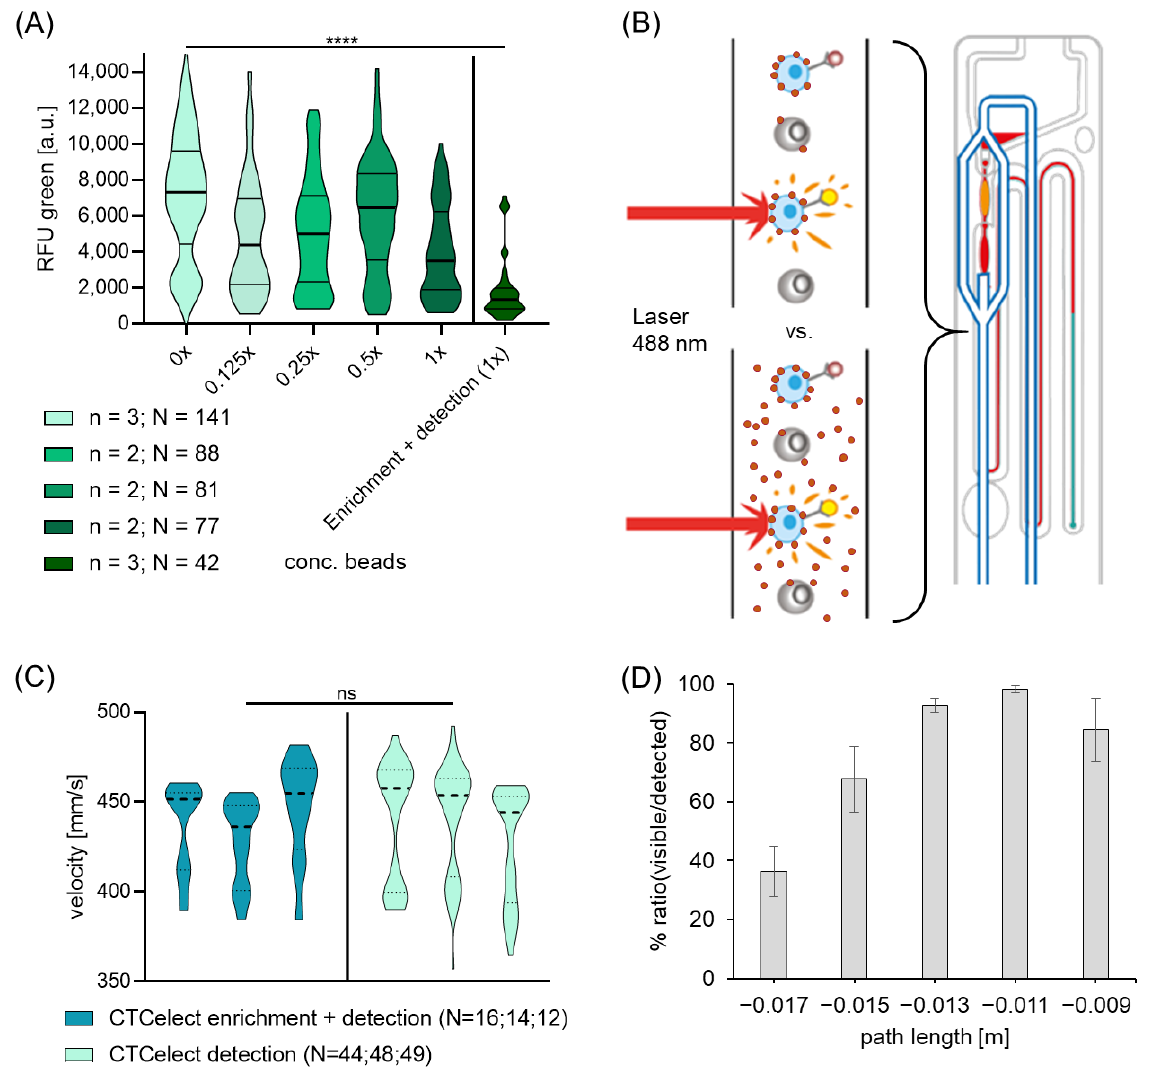
Figure 3. Characterization of fluorescence and flow properties of bead-bound single cells. ( A ) The relative fluorescence intensity of CFSE stained bead-bound MCF-7 cells (in RFU) was recorded with our microfluidic flow cytometry subunit in dependency of free beads in the channel ( x -axis) and previous automated enrichment. Relative fluorescence is presented as violin plot with median and first and third quantile (one-way anova, with Tukey’s multiple comparisons test, **** p < 0.0001). ( B ) Explanatory illustration of single cell detection in the microfluidic cartridge with or without free beads. ( C ) The velocity of bead-bound single cells was measured in the detection channel of the chip and compared between manual bead incubation (436 mm/s) and previous automated immunomagnetic enrichment (437 mm/s). Velocity is given as violin plot with median and first and third quantile (paired t -test, p ns = 0.88). ( D ) Empirical determination of ideal path length correction to time the dispensing trigger. The set path length correction is displayed against the ratio between software detected and visible cells after